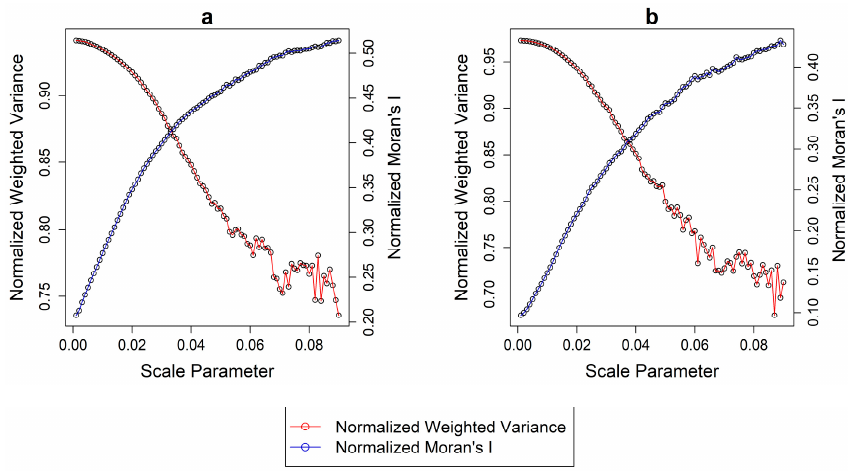
Figure 3. Normalized MI and WV values for each computed segmentation for ( a ) ROI 1 and ( b ) ROI 2 using the FT approach.